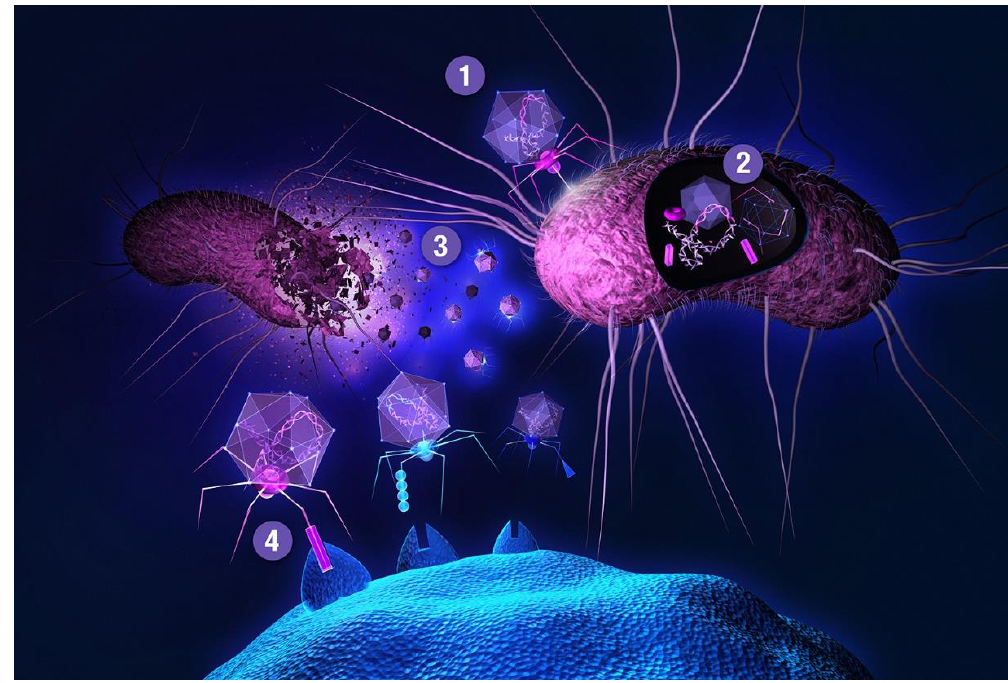
Figure 2. Iterative principle of phage display library screening. Recombinant phage DNA is packed into viral particles in vitro (common for T7- and lambda phage-based systems) for transduction of genetic library into host bacteria ( 1 ). Alternatively, phage DNA can be electroporated into host cells (typical for filamentous phage-based systems; not shown). Exploiting bacterial transcription and translation mechanisms, progeny virions displaying foreign peptides are amplified and assembled ( 2 ), and released into growth medium ( 3 ). Amplified library is isolated and purified, and contacted with an immobilized target ( 4 ). Non-bound clones are removed by stringent washing, while those retained due to target:displayed peptide interaction are eluted and collected for amplification in host bacteria before being subjected to further selection rounds.